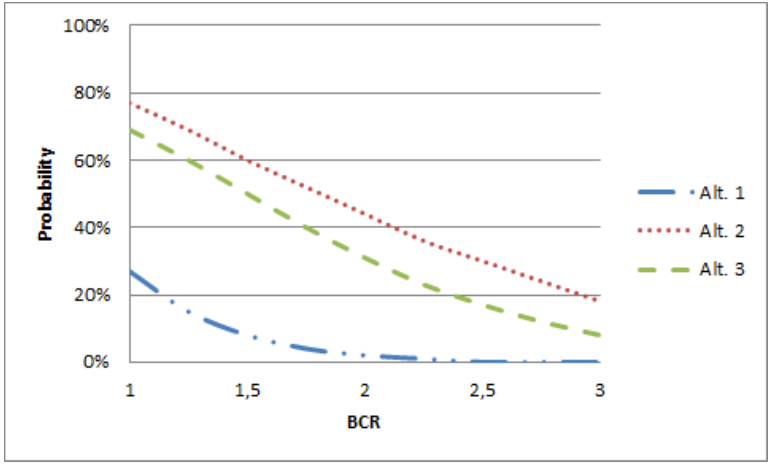
Figure 8. Certainty graphs for the three